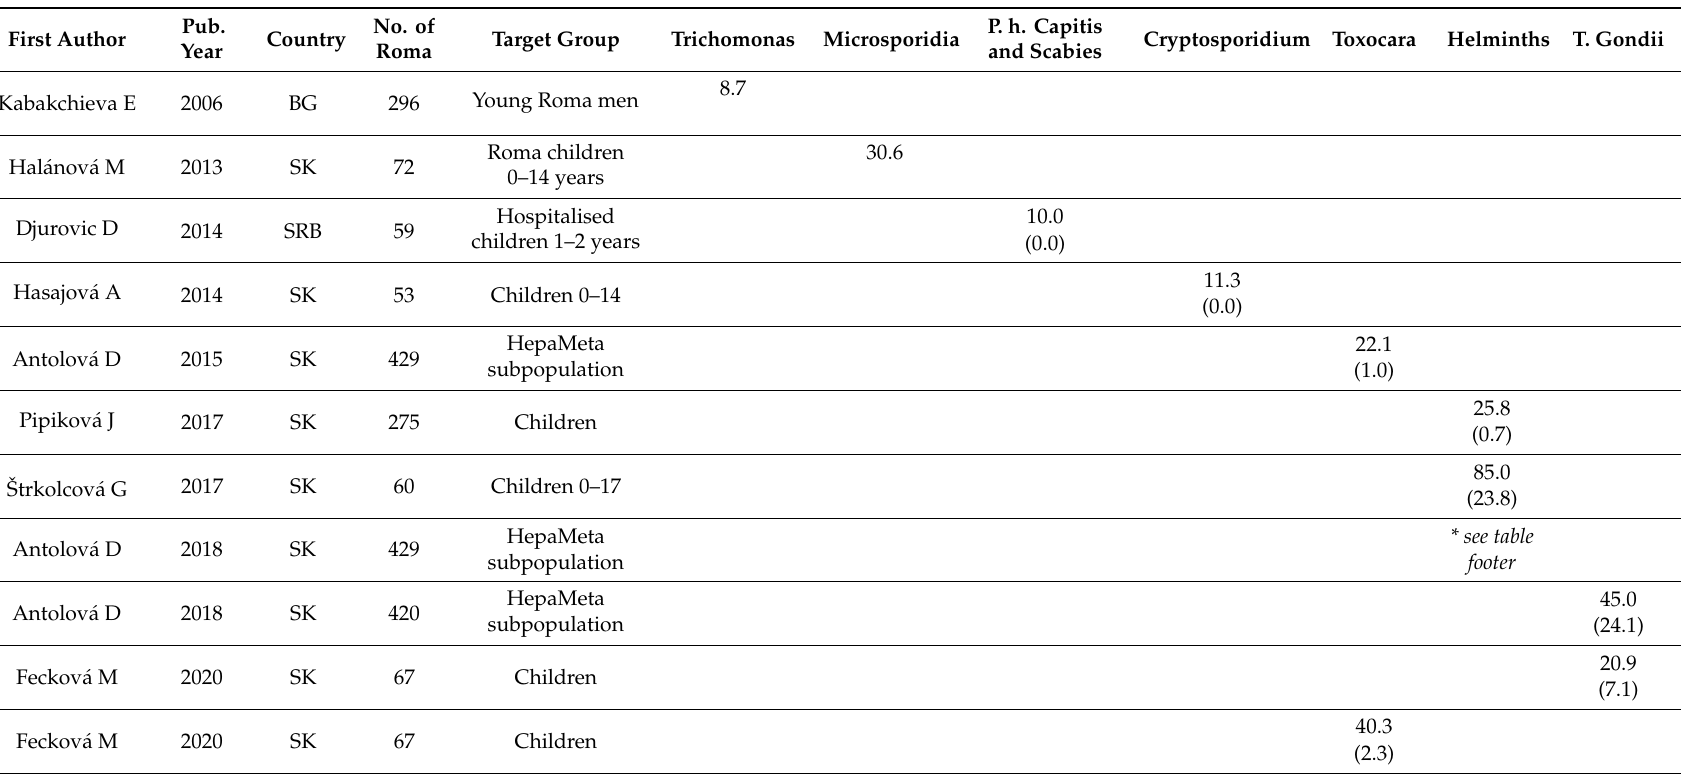
Table 3. Parasitic disease (per